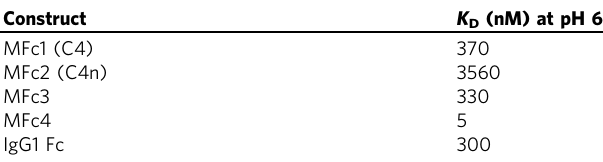
Table 2 Equilibrium binding of monomeric Fc variants to human FcRn in a recombinant 1:1 binding format.